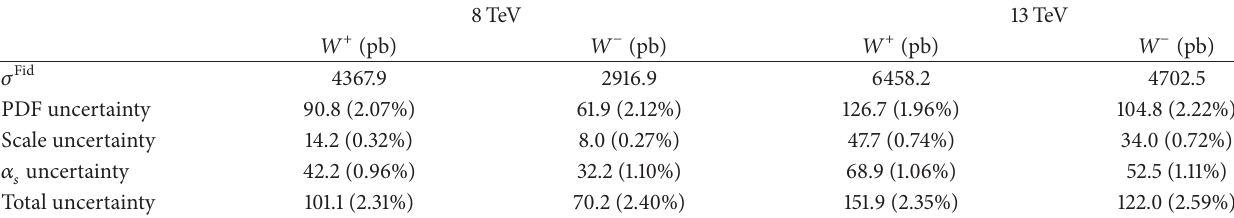
Table 4: Predicted fiducial cross section numbers with NNPDF 3.0 with NNLO QCD corrections at 8TeV and 13TeV center of mass energies. All numbers are in units of pb. Relative uncertainties are expressed in